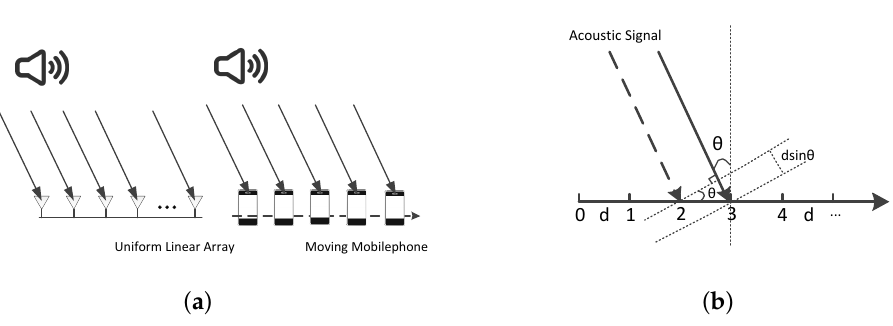
Figure 2. ( a ) Uniform linear array simulation; ( b ) virtual uniform linear arrays geometry analysis.